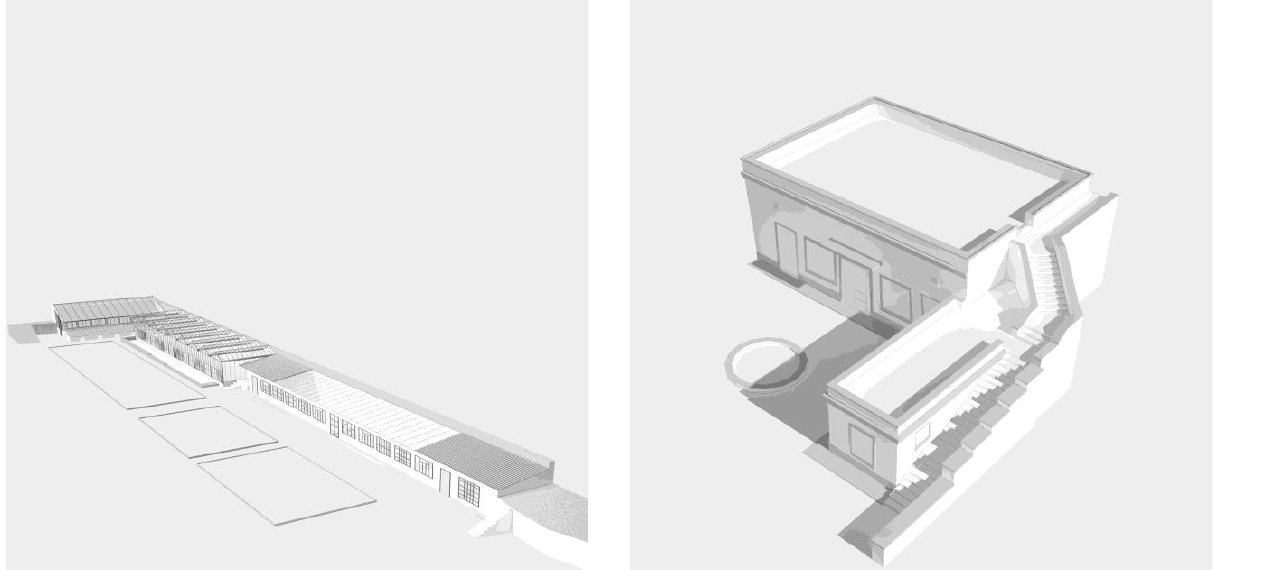
Figure 10. The Royal Park of Tirana. 3D survey of greenhouses. Figure 11. The Royal Park of Tirana. 3D survey of the generator